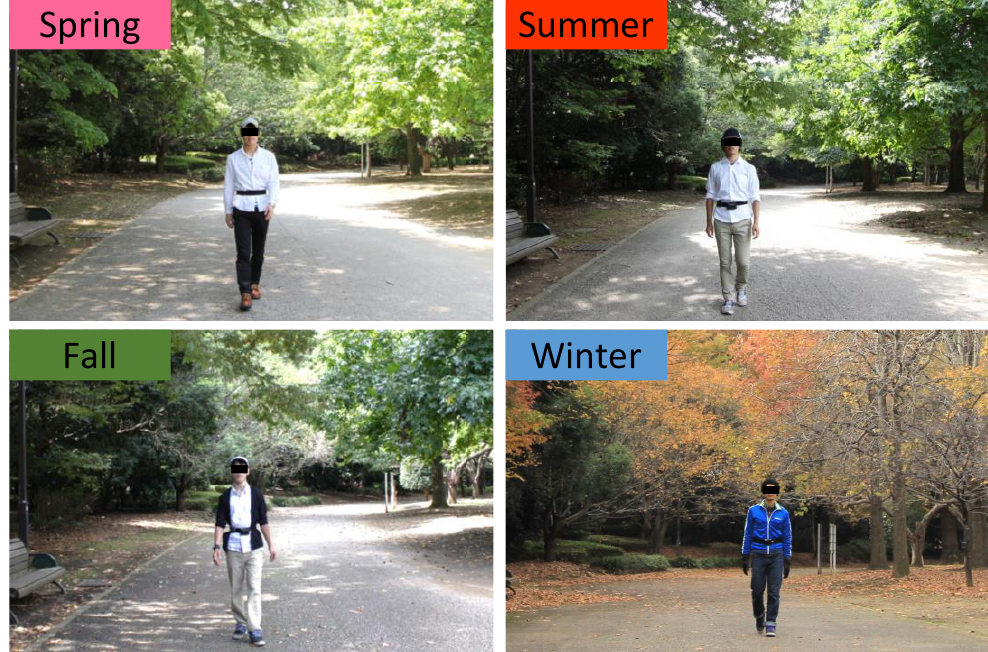
Figure 1. Experimental scene in the urban park. The top left photo (spring), bottom left photo (fall), and bottom right photo (winter) are reprinted from Song et al. (2014) [20], Song et al. (2015) [21], and Song et al. (2013) [22], respectively.